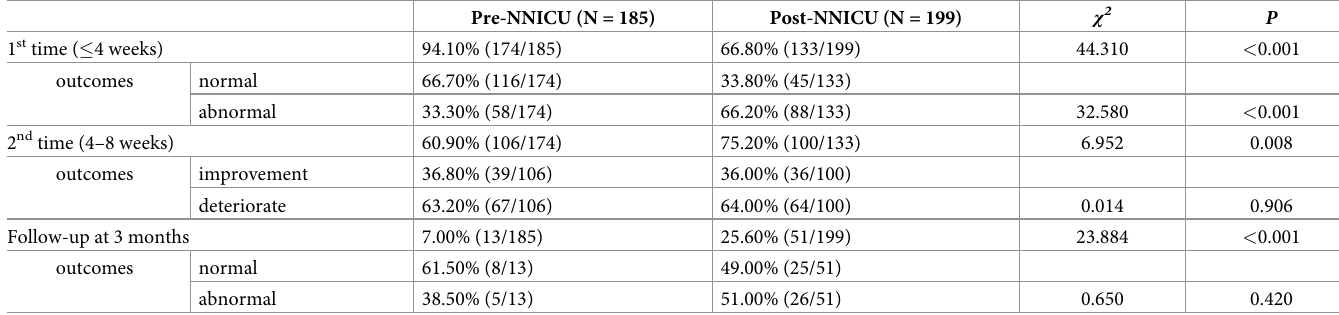
Table 5. The assessment of neurodevelopment for the